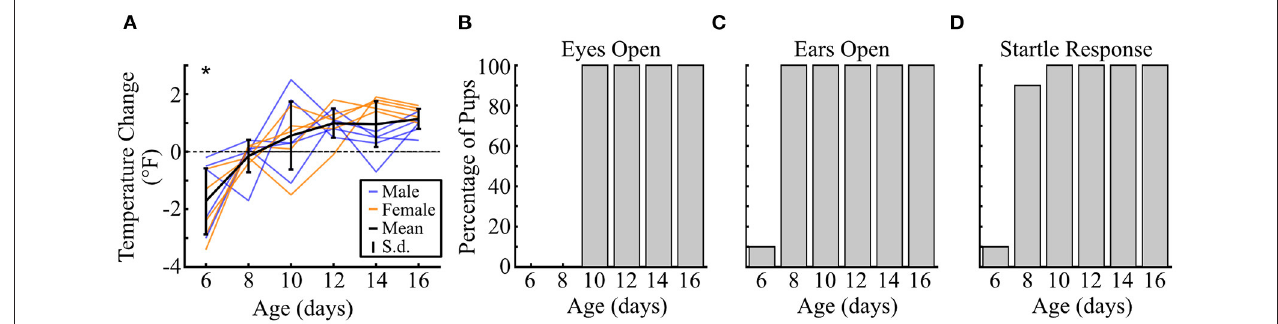
FIGURE 9 | Prairie vole pup developmental timeline. (A) Change in temperature of individual pups after 10min of isolation. Negative values indicate a decrease in temperature. Colored lines represent individual animals over time, with males in blue ( n = 5) and females in orange ( n = 5). Solid horizontal black line indicates mean value, with vertical lines showing standard deviation. Dashed line shows location of 0, or no change in temperature. * p < 0.05, distribution compared to zero with a one-tailed t -test. (B) Bar plots show the percentage of pups at each age (B) with open eyes, (C) with open ears, and (D) exhibiting a startle response to a loud